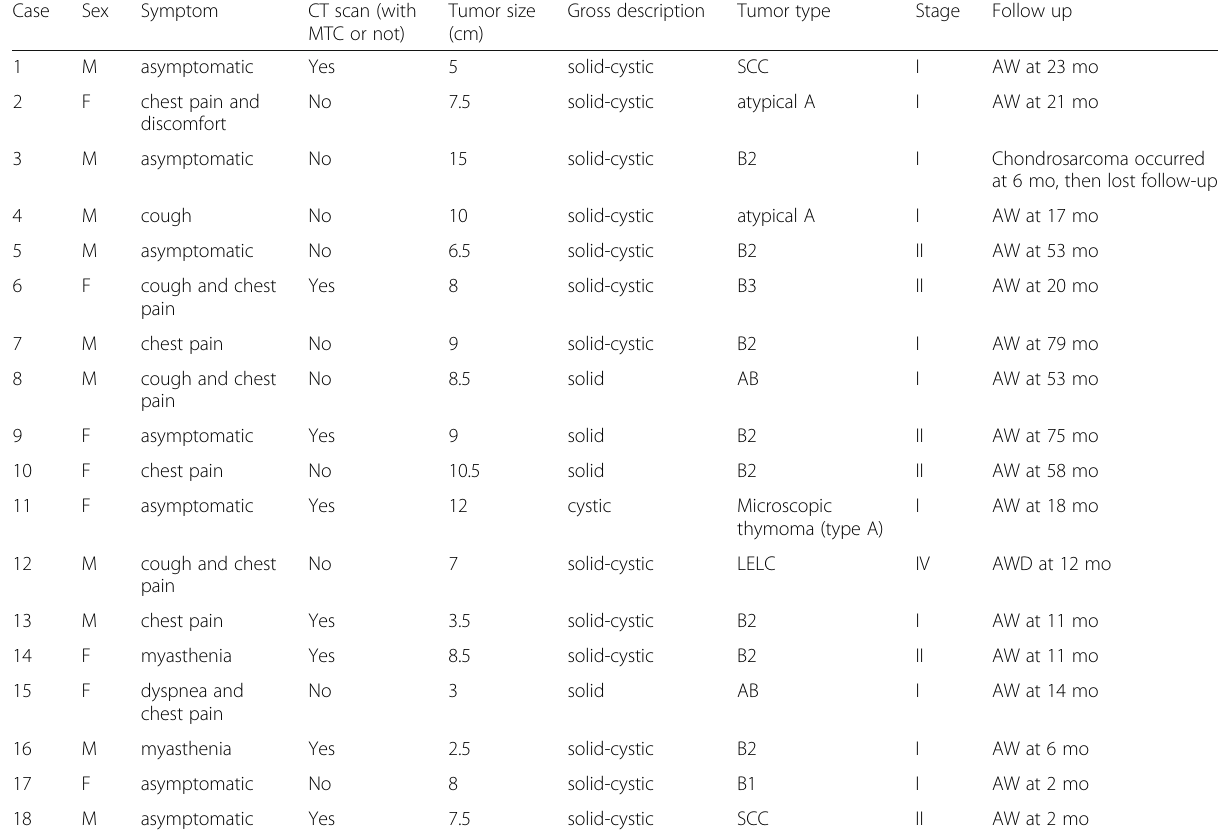
Table 1 The clinicopathologic features of the 18 patients with thymomas and TCs associated with MTCs